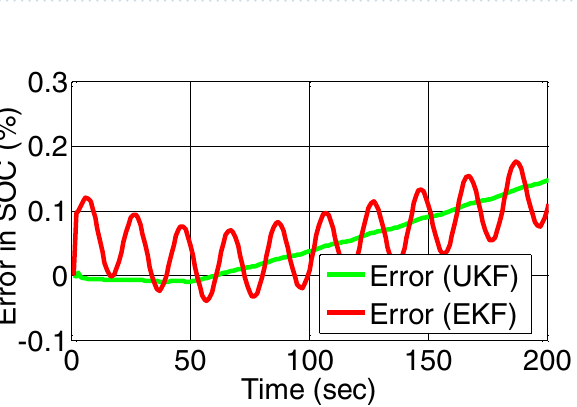
Figure 5. SOC estimation by EKF and UKF on simulated battery model.